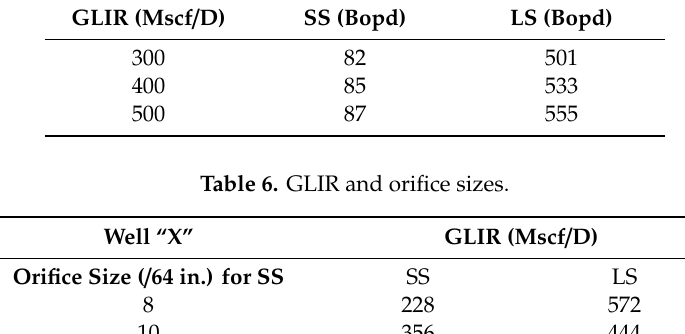
Table 5. GLIR sensitivity against production.